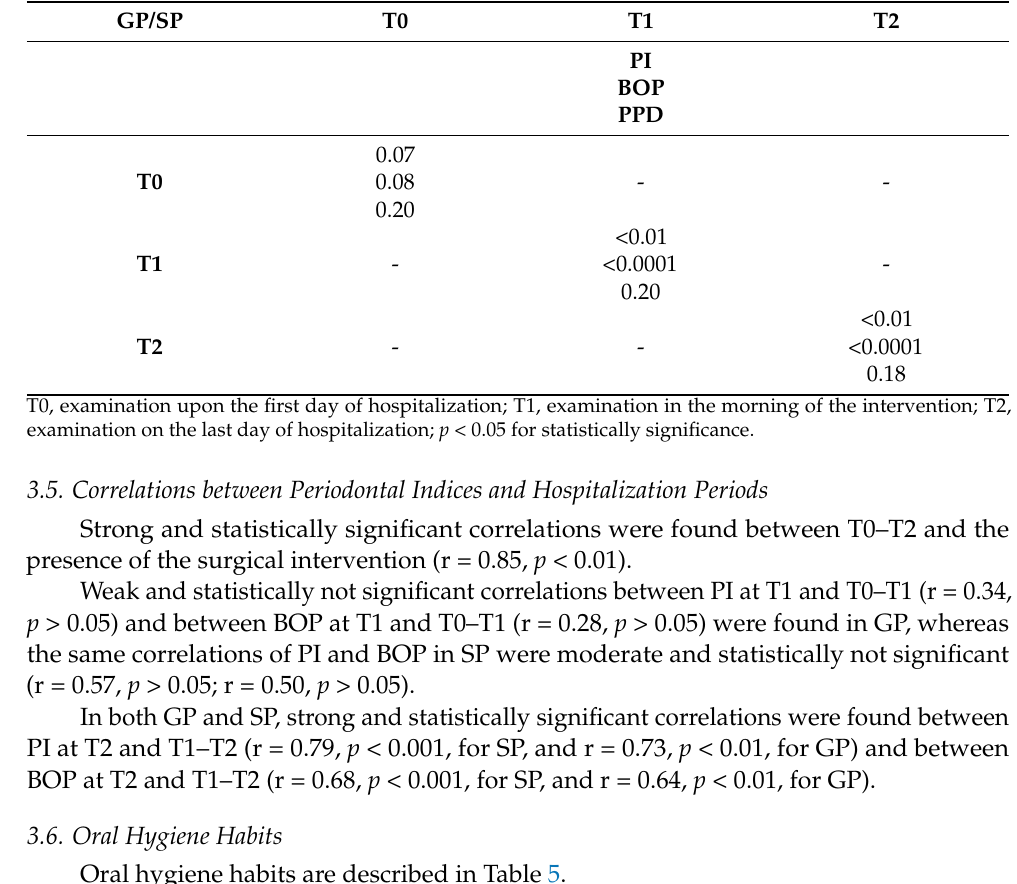
Table 4. Differences between groups GP and SP at T0, T1, and T2 regarding PI, BOP, PPD (p